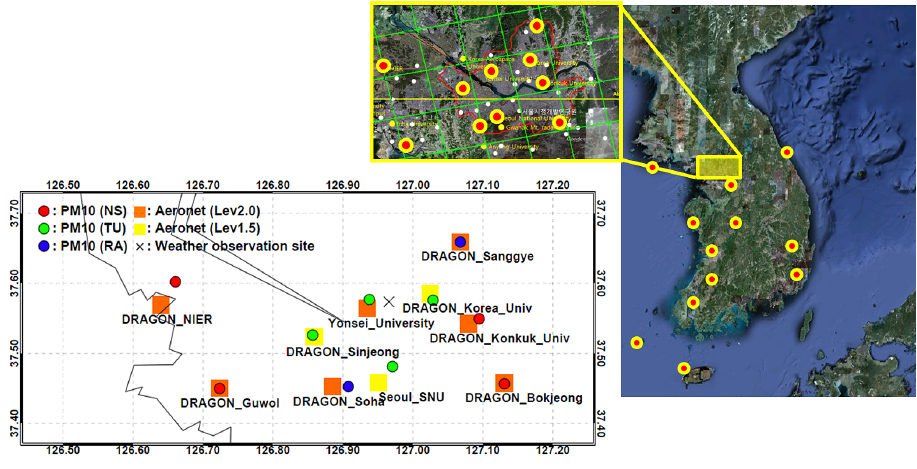
Figure 1. The spatial distribution of AERONET stations, PM 10 monitoring sites, and weather observation sites across the Seoul metropolitan area. Orange and yellow boxes indicate the locations of AERONET level 2.0 and 1.5 sites, respectively. The colored circles denote the locations of PM 10 monitoring sites. Red, green, and blue sites represent near-source (NS), typical urban (TU), and residential area (RA) site types, respectively.